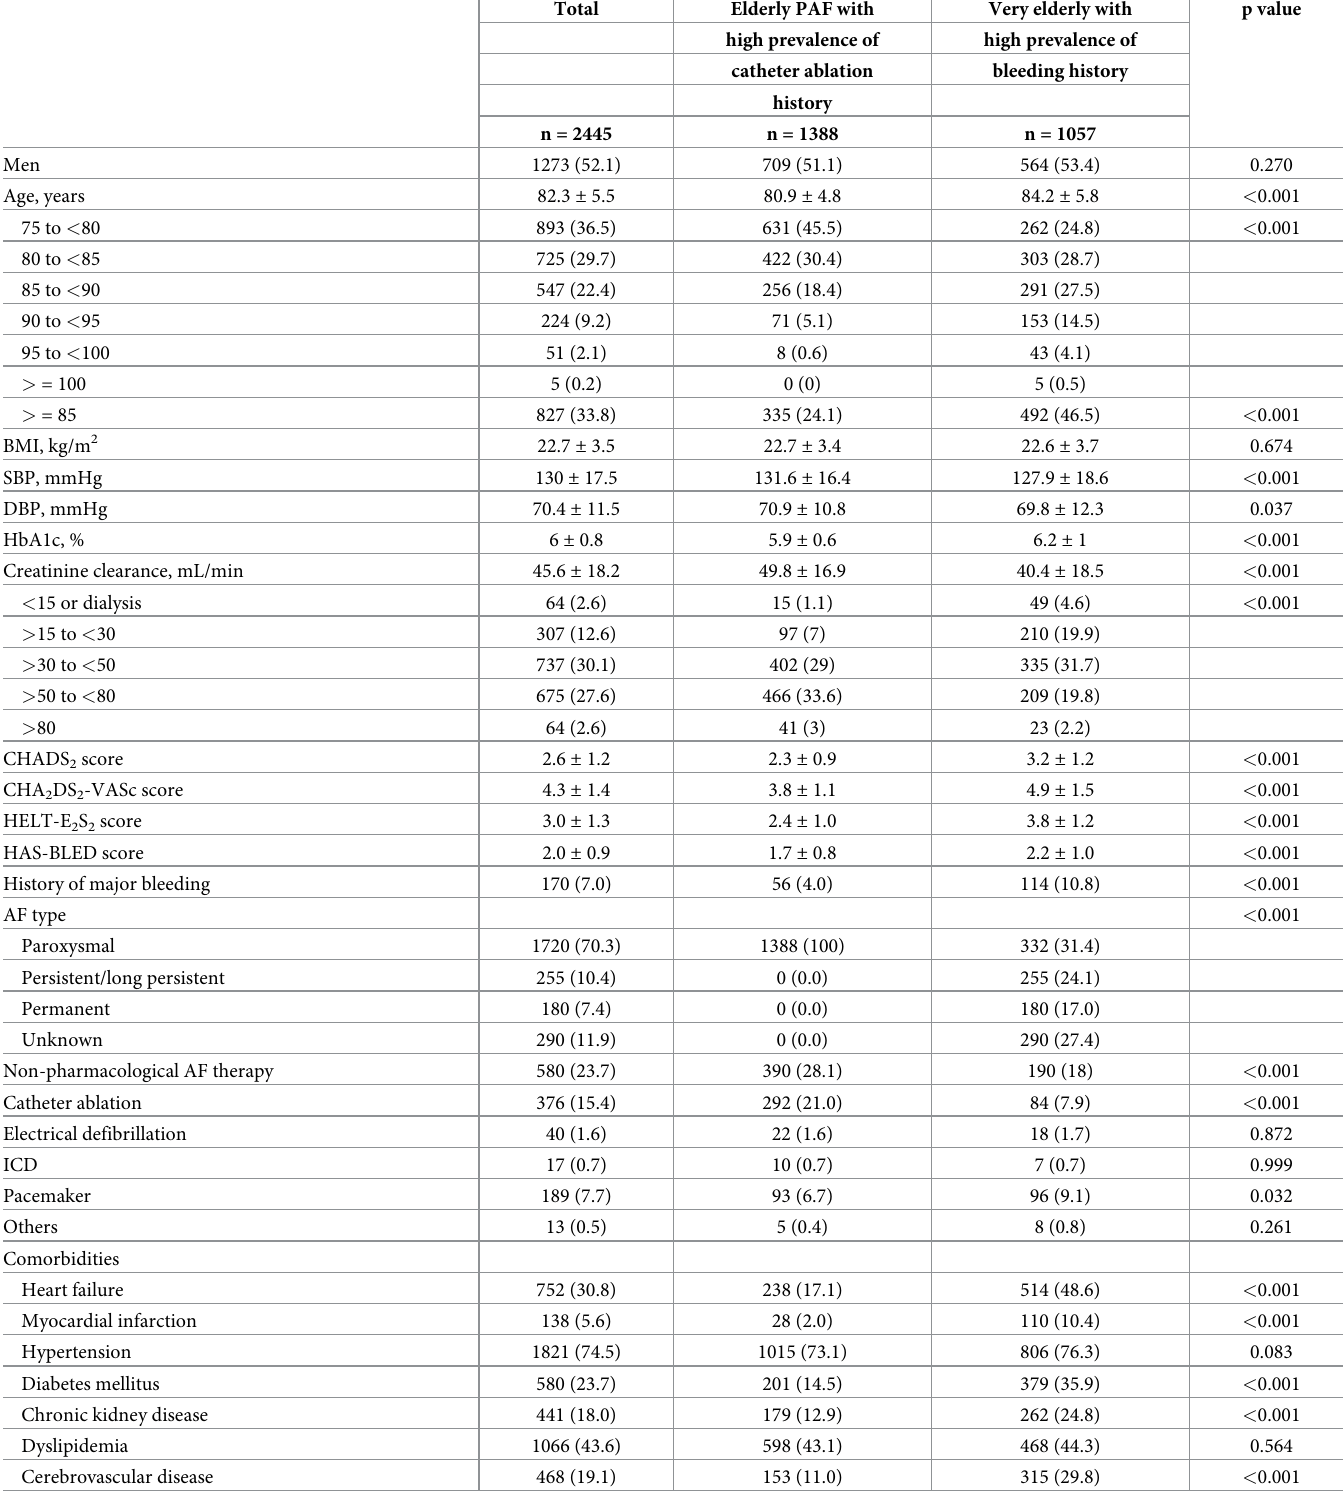
Table 1. Patient